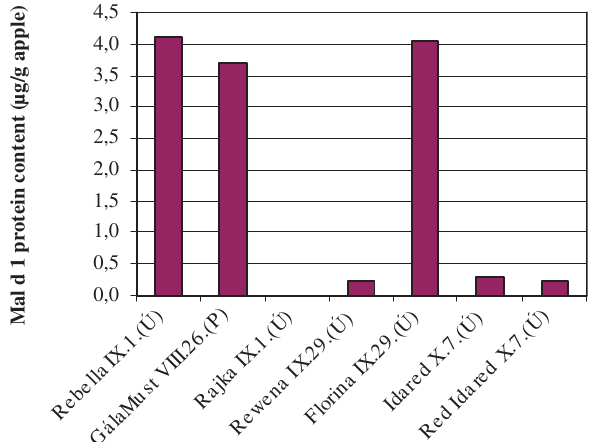
Figure 3. Protein content of Mal d 1 allergen fraction from different apple varieties cultivated under integrated